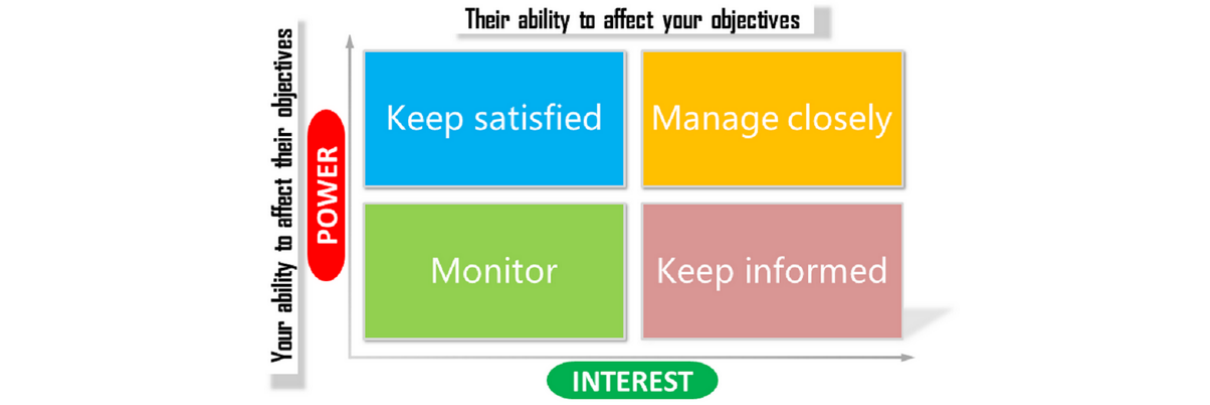
Figure 1. A simple stakeholder management model (adapted from Freeman and Reed